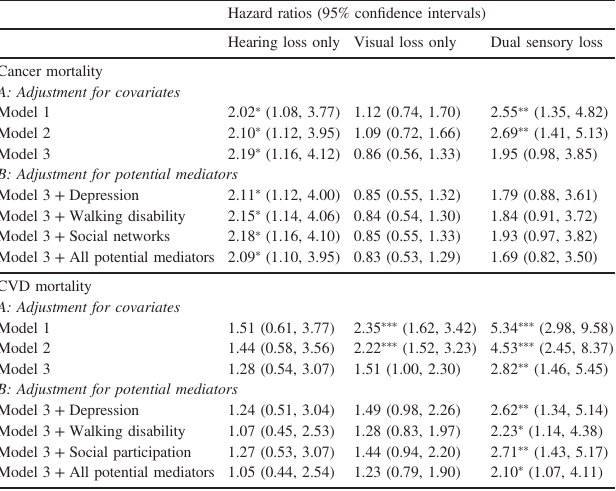
Table 2. The association between sensory loss status and all- cause mortality Hazard ratios (95% con fi dence intervals)